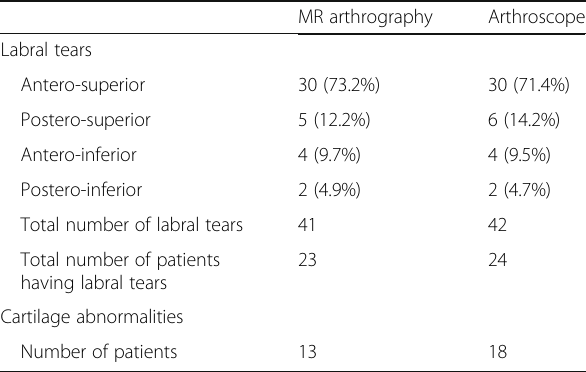
Table 3 The number of labral tears at different quadrants and the number of patients having chondral abnormalities as detected by MR arthrography and arthroscopy in FAI patients